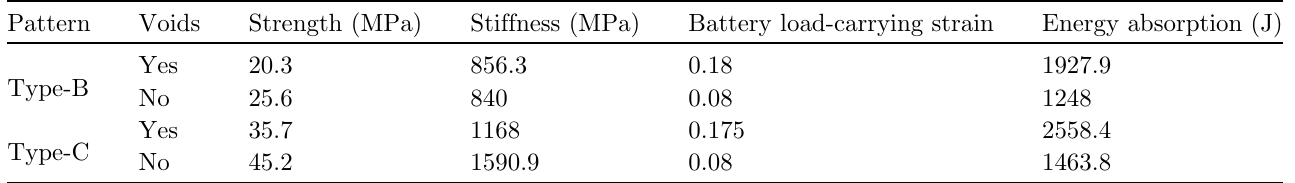
Table 3. Summary of mechanical properties of the multifunctional systems with multiple battery